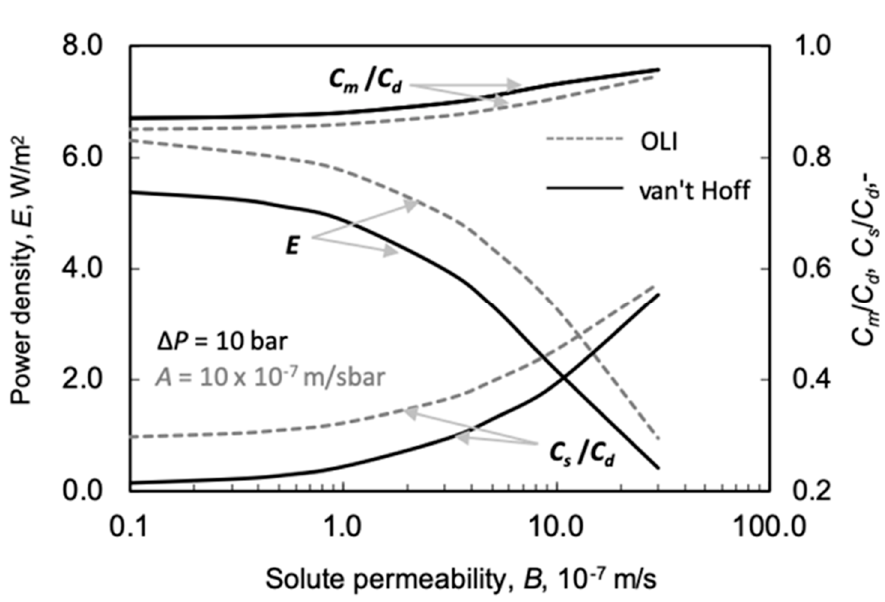
Figure 9. Power density and concentration of the membrane active layer as a function of the solute permeability (Remained parameter are given in Table 2).